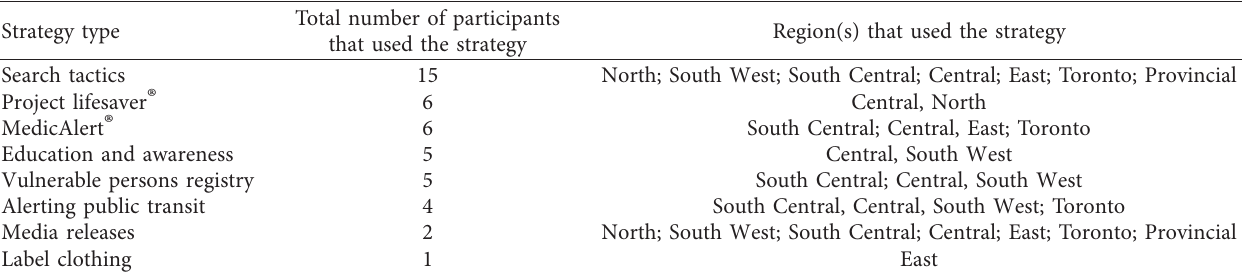
Table 2: Strategies used by police for lost persons with dementia.